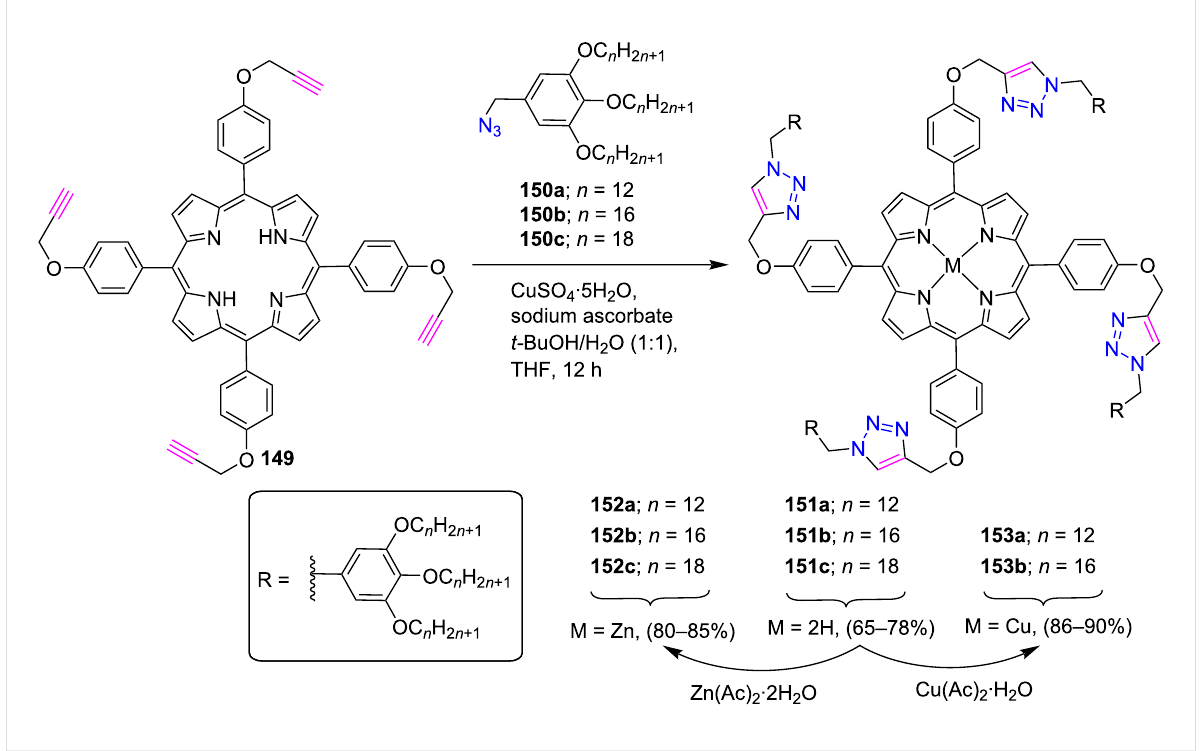
Scheme 32: Synthesis of meso -tetratriazole-linked porphyrin conjugates 151–153